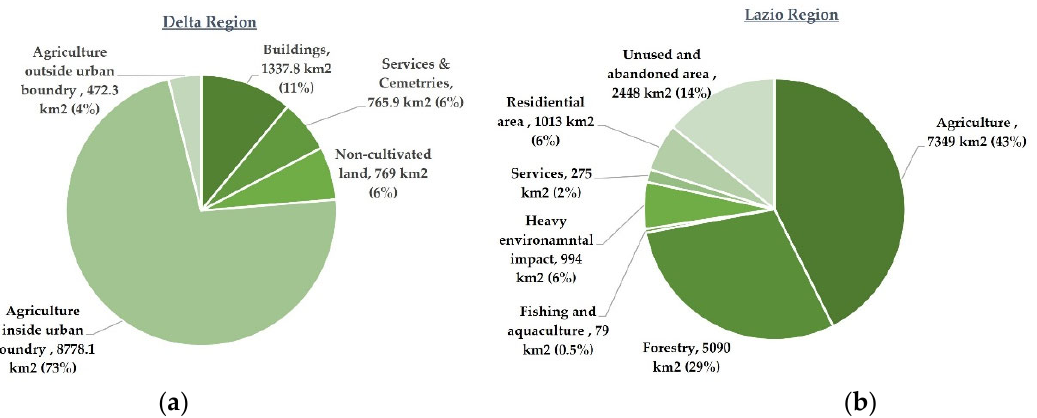
Figure 8. Land use distribution by activity. ( a ) In the Delta region [98]; ( b ) in the Lazio region [109]. The buildings and agricultural land use represent 88% in the Delta and 49% in the Lazio, highlighting the potential of the concept we promote (multifunction land use) in contributing to both regions. The total farm numbers in Italy in 2016 accounted for 1,145,705 farms, distributed over an area of 16,525,472 hectares (hereafter ha) (one hectare equals 1000 m 2 ). In Lazio, the total number of farms is 68,295 (Figure 9b), distributed over 827,588 ha (Figure 9a). They exemplify 5% of the national farm areas. Of note, the number of farms in Lazio is decreasing steadily. For instance, in 2016, farm numbers dropped by 17% compared to 2013 and 30% compared to 2010, whereas in terms of area, the total farm areas in 2016 decreased by 4% compared to 2013, adding a new challenge for Italy to preserve the remaining farmlands.